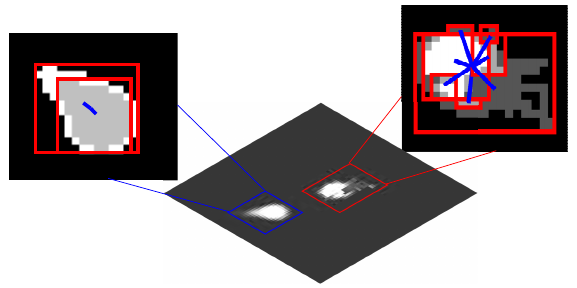
Figure 9. Comparison of structural